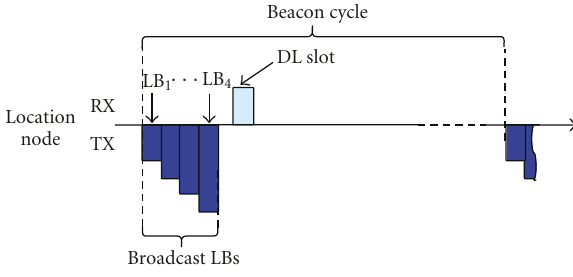
Figure 13: LB transmissions with